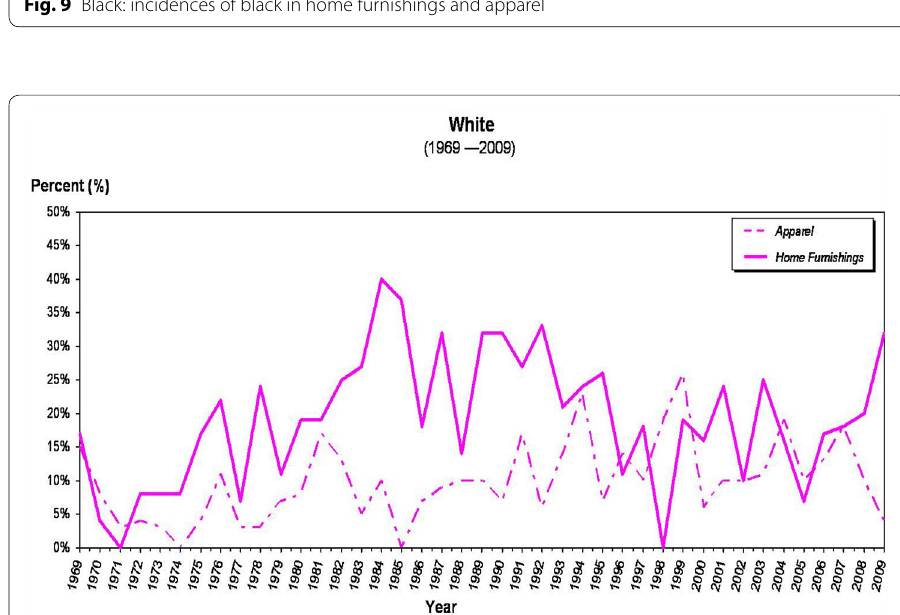
Fig. 10 White: incidences of white home furnishings and